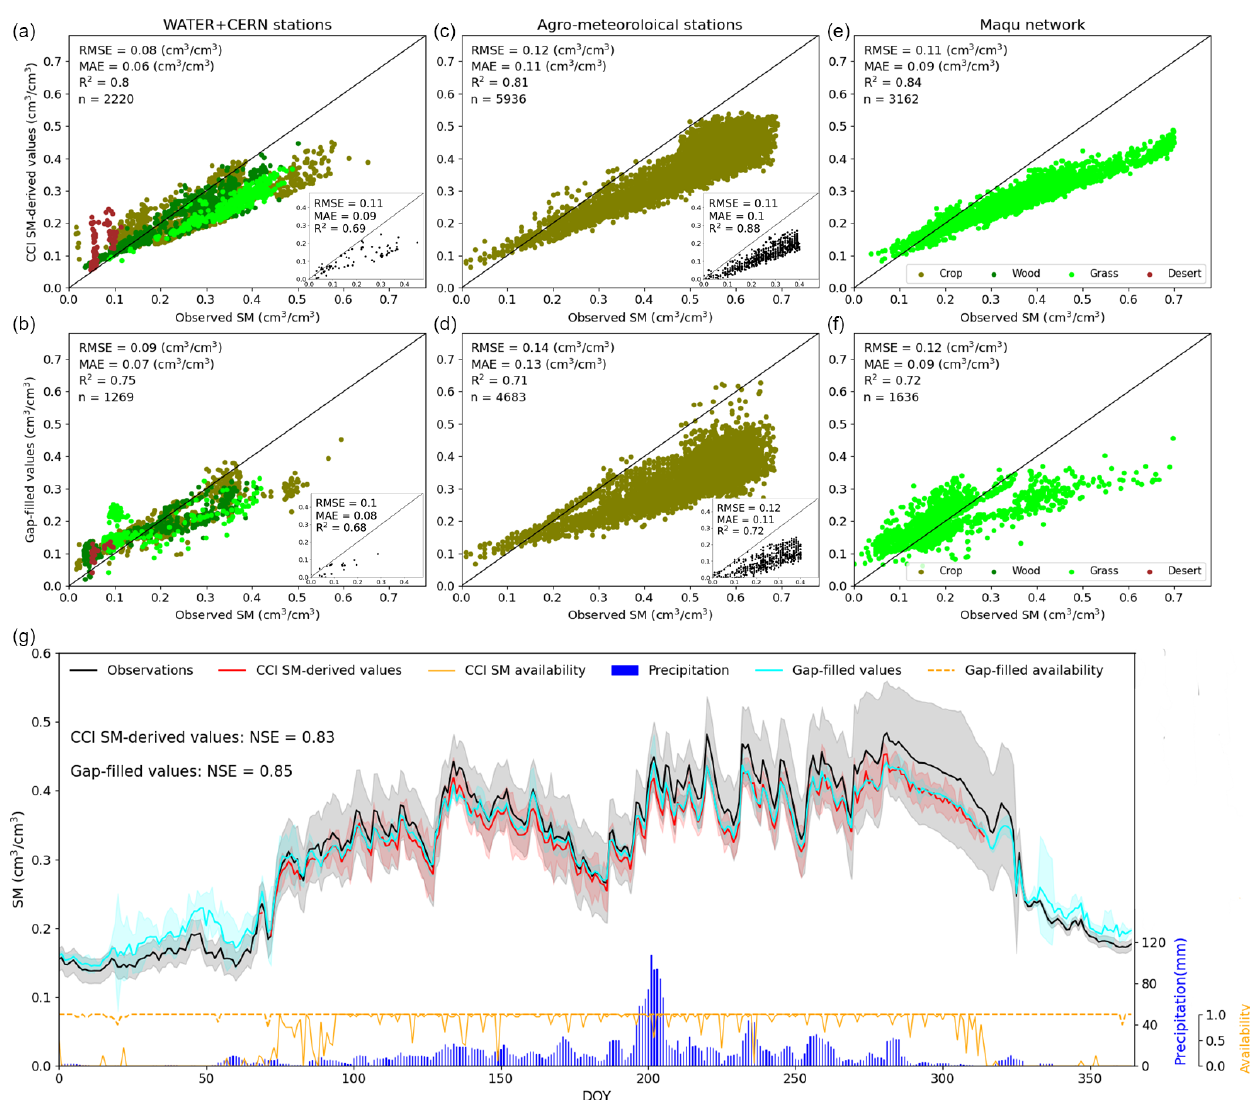
Figure 7. Evaluations of model results. Panels (a) , (c) , and (e) are the scatter plots of 1km CCI SM-derived values against field measures regarding WATER/CERN, agrometeorological stations, and the Maqu network, respectively, and panels (b) , (d) , and (f) are the scatter plots of 1km gap-filled SM-derived values against field measures. The subfigures in the upper corners of panels (a) – (d) are the scatter plots under extremely dry conditions. Panel (g) is the time series of average CCI SM-derived values against site measures in the Maqu region. The shaded area in panel (g) denotes ± 1 standard